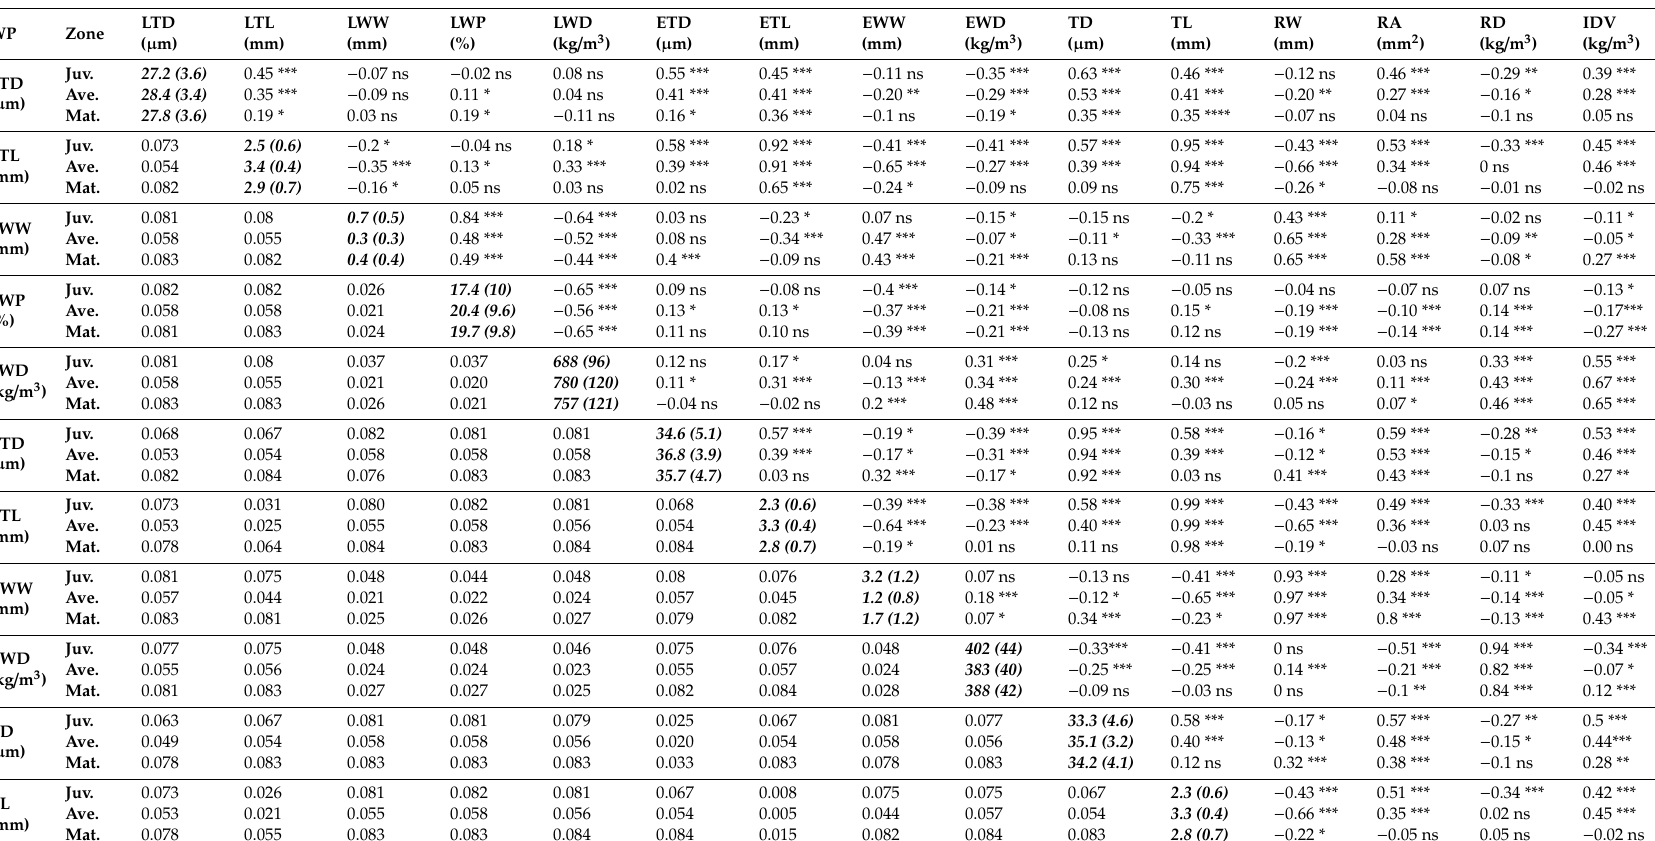
Table 2. On the diagonal, in bold and italic, the mean and standard deviation (between parentheses) of the 15 wood properties measured at breast height. Above the diagonal, intra-ring Pearson’s correlations between radial growth-related properties, anatomical properties, and density-related properties for the whole ring, earlywood zone, latewood zone, whole pith-to-bark radial section, juvenile wood zone, and mature wood zone. Below the diagonal, standard errors of the Pearson’s